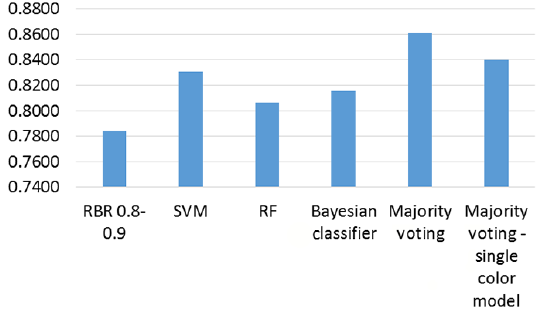
Figure 6. Detection accuracy with different Thr PCA settings in Eq. (5) at each level using SVM.